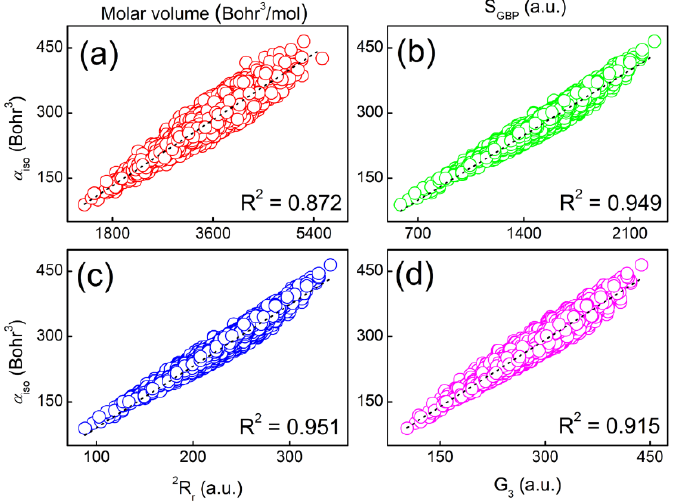
Figure 4. Strong correlations between molecular polarizability and ( a ) molecular volume, ( b ) S GBP , ( c ) 2 R r , and ( d ) G 3 for a total of 20 amino acids, 400 dipeptides, and 8000 tripeptides. Computations were carried out at the M06-2X/Def2-TZVP//M06-2X/Def2-SVP level.